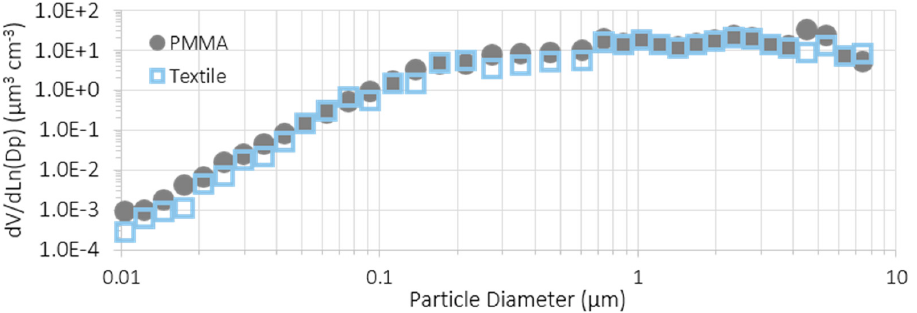
Figure 10. Volume aerosol size distributions for TiO 2 -N sprays over different substrates in the NF station.